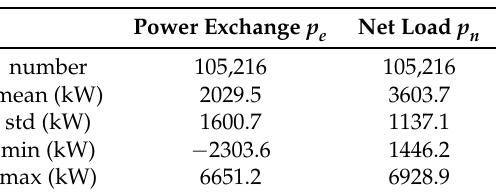
Table 1. Number of samples for power measures available for the Borkum grid. Three years, with 15 min frequency, of power measures in two measurement points are available. The minimum, maximum, mean values, and the standard deviations are listed.